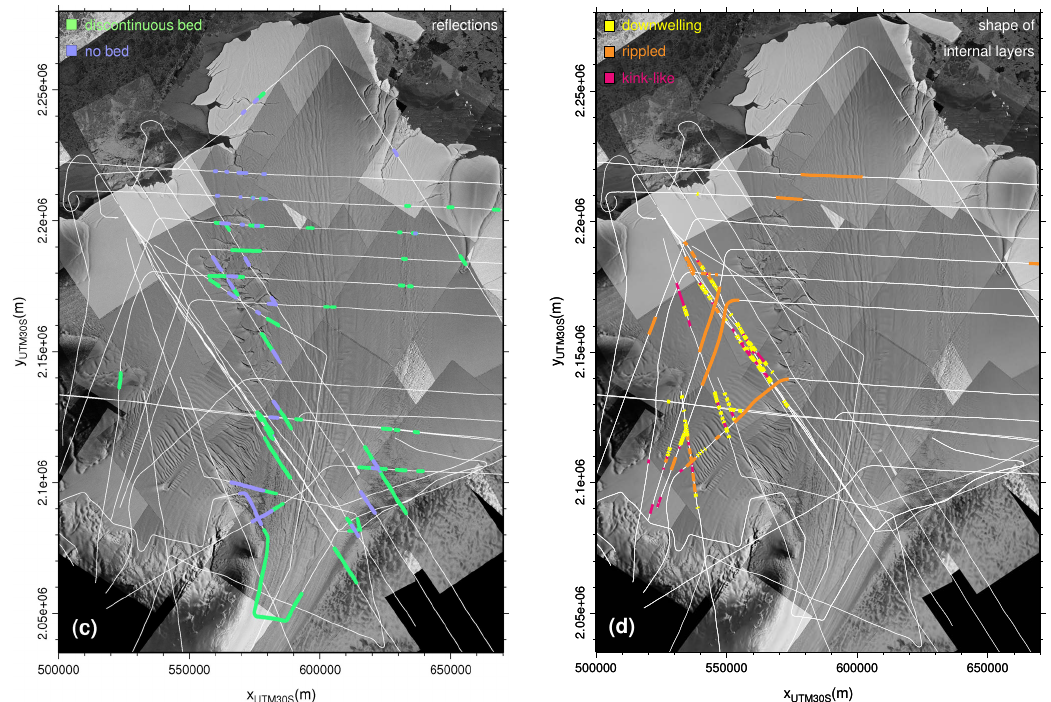
Fig. 4. Second two of four images displaying the RES classification of the internal structure superimposed on the TerraSAR-X mosaic. (c) Reflections: blue missing bottom reflection, green discontinuous reflections. (d) Shape of internal layers: down-welling in yellow, rippled shape in orange and kink-like in pink.